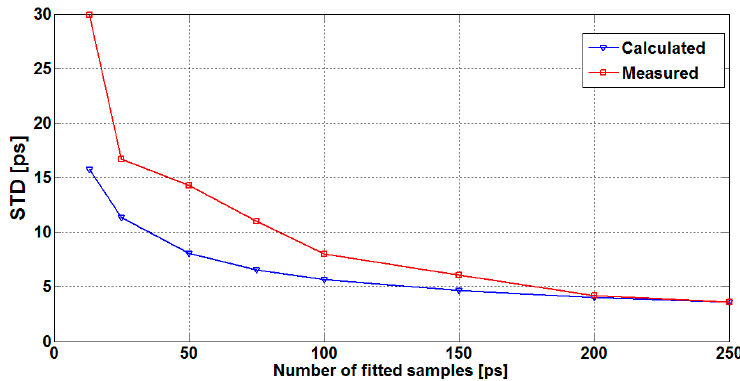
Figure 9. TTD standard deviation versus the number of fitted samples (N).